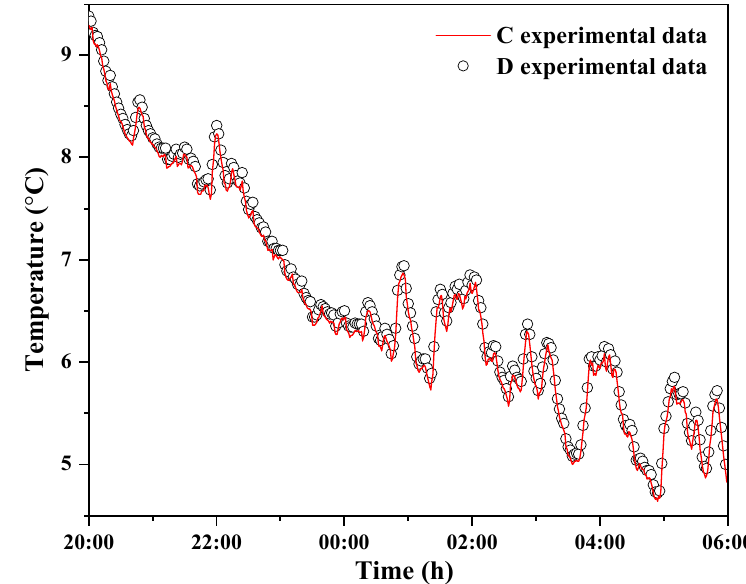
Figure 13. Temperature variation of the MHP evaporation and condensation sides with time.